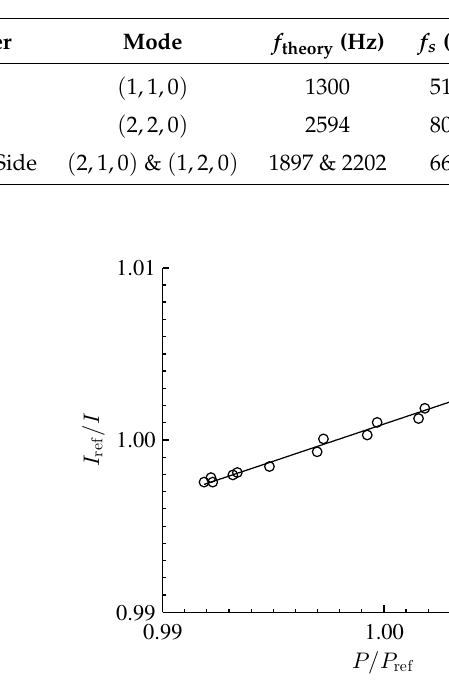
Table 1. Summary of test conditions.